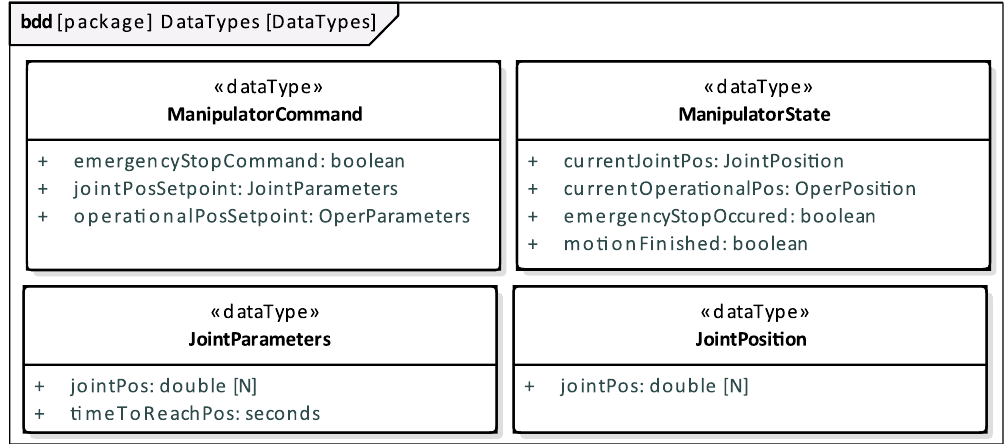
Figure 9. dataTypes transmitted within the System.